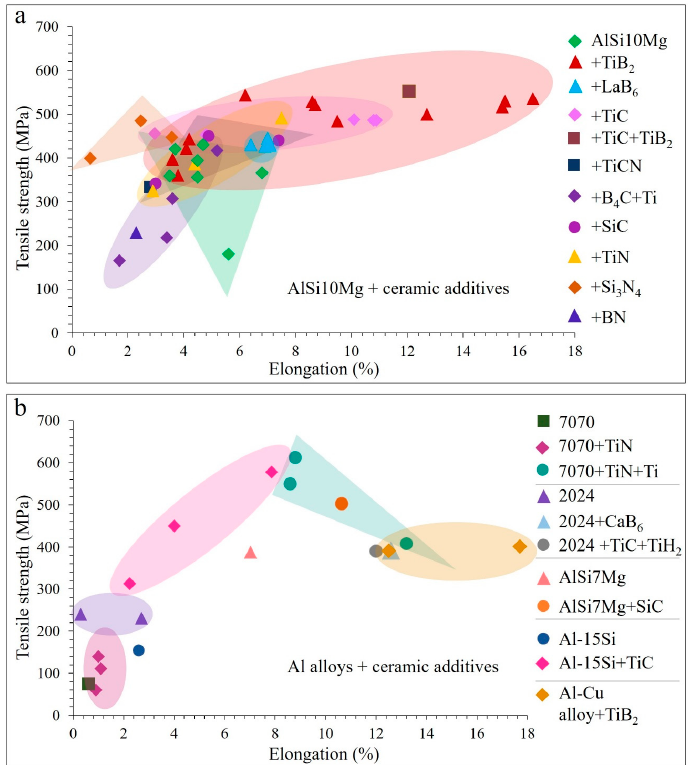
Figure 23. Tensile strength and elongation results of LPBF prepared ceramic particulate reinforced AlSi10Mg ( a ) and other Al alloys ( b ) (data from [8,28,31,50,59,66,71,73,77,79,80,82,84,88– AlSi10Mg ( a ) and other Al alloys ( b ) (data from 98,101,103,104]).